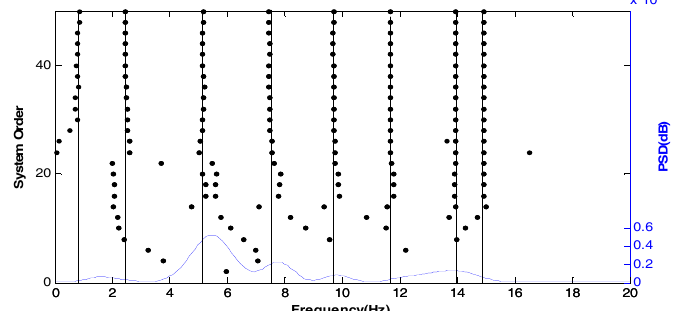
Figure 7. Stabilization diagram in the Z direction of the test point 1 under normal conditions.